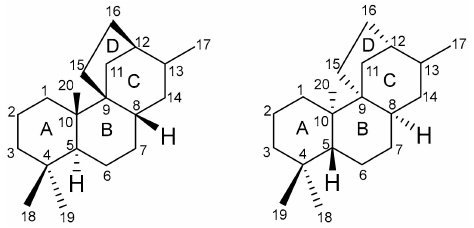
Figure 5. Stemarane (left) and ent -stemarane (right) diterpenes carbon